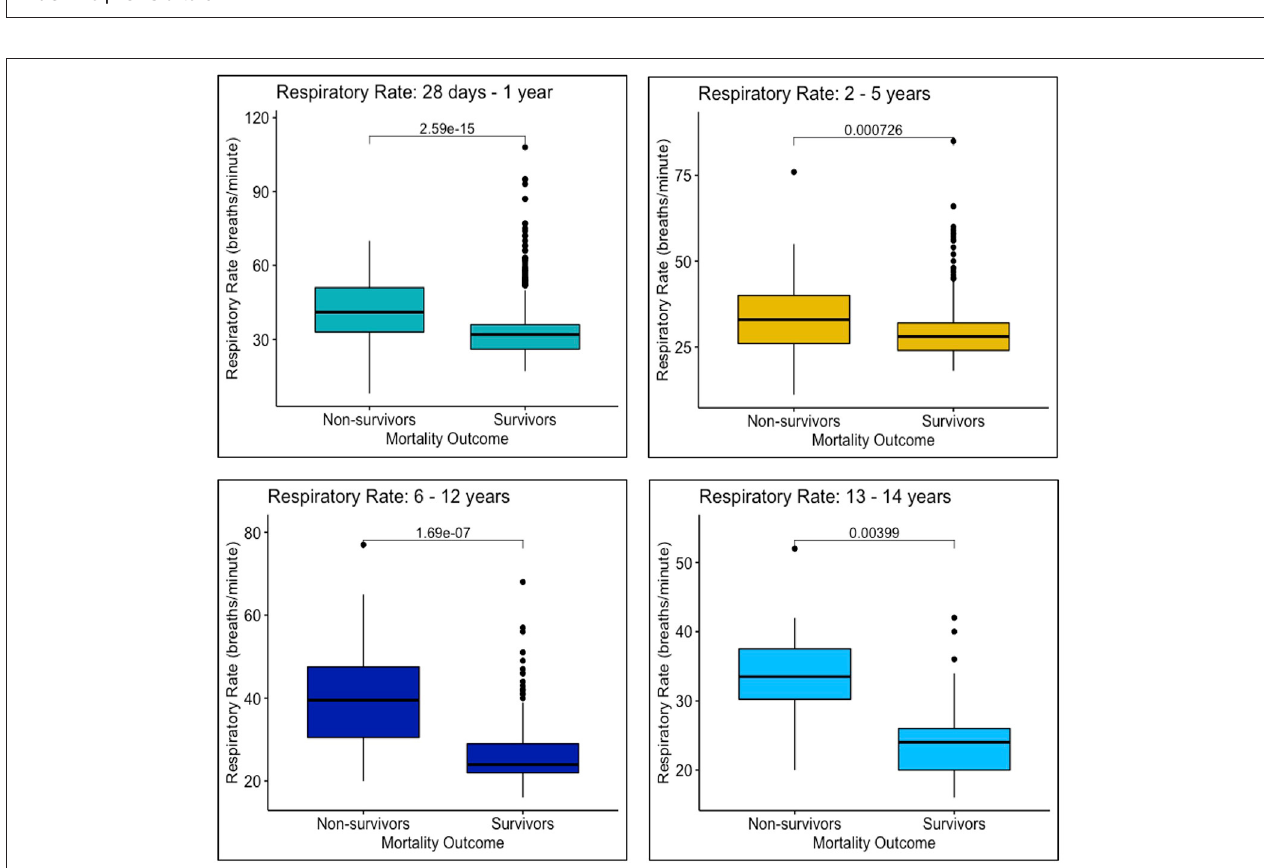
FIGURE 4 | Respiratory rates upon arrival to MNH of survivors and non-survivors in each age group: 28 days − 1 year, 2–5 years, 6–12 years, and 13–14